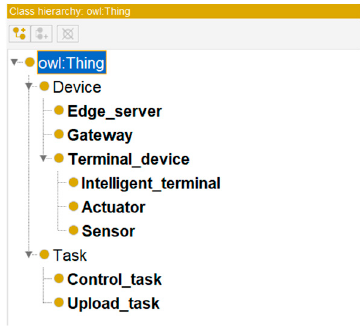
Figure 4. IoT device ontology classes and class